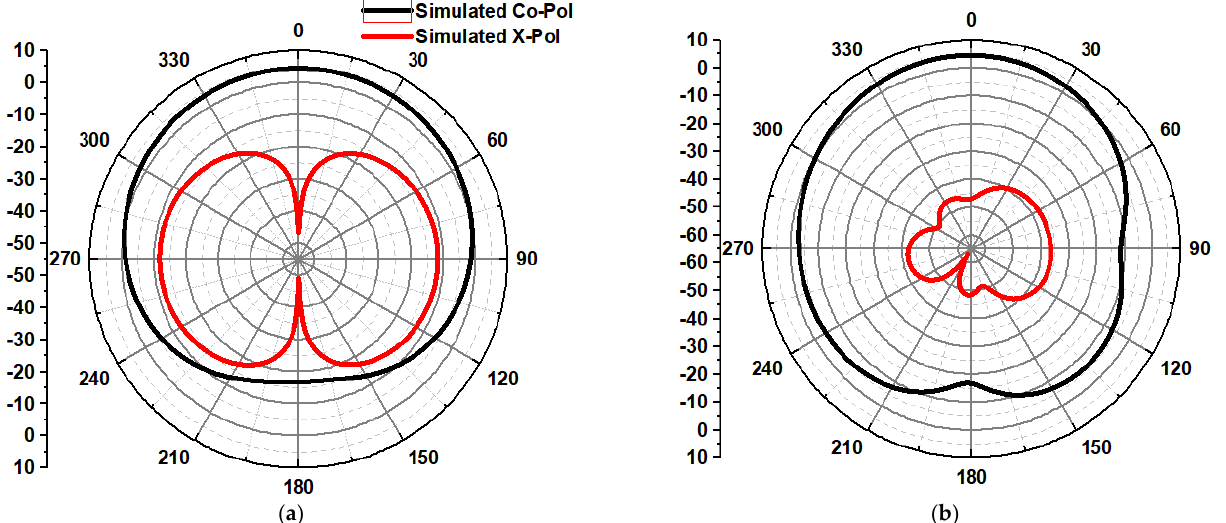
Figure 9. The radiation pattern of the proposed antenna at 28 GHz ( a ) E ‐ plane and ( b ) H ‐ plane.